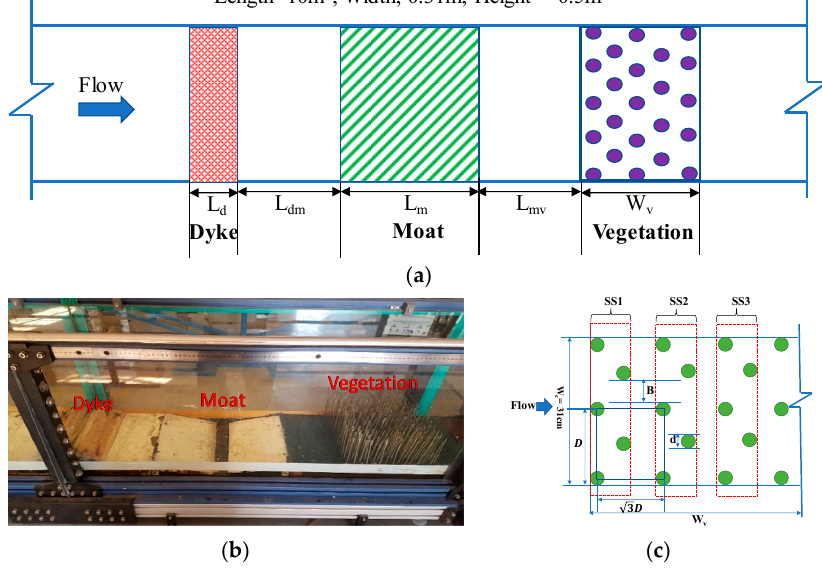
Figure 2. Experimental setup: ( a ) Schematic of the channel with models, ( b ) experimental setup of the hybrid defense system in the laboratory, ( c ) vegetation arrangement details of staggered strips